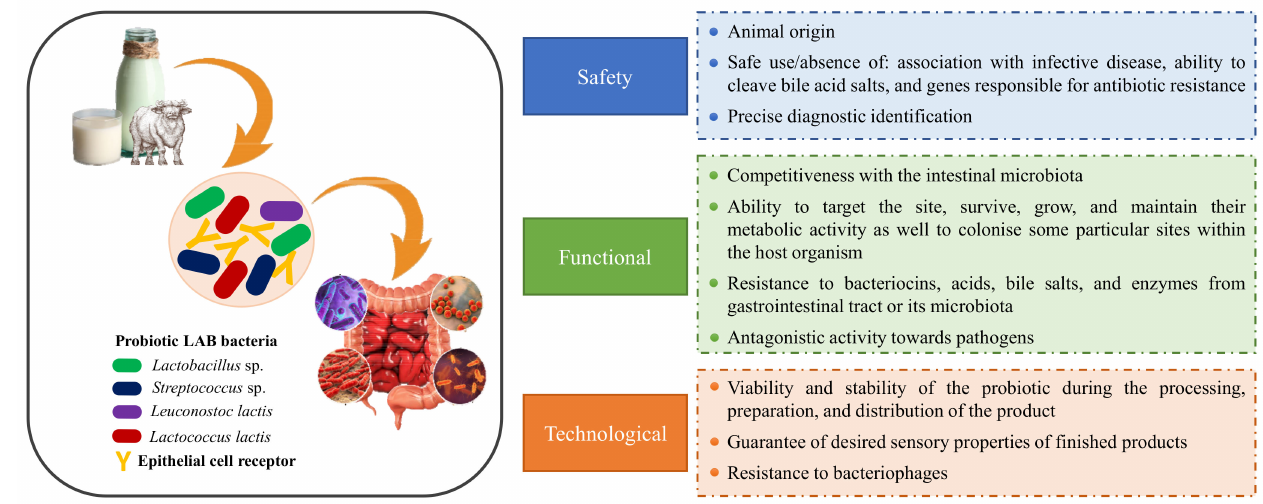
Figure 1. Selection criteria that should be applied to raw buffalo milk and its products to consider its microbiota as probiotic strains concerning its safety, functional, and technological properties. Adapted from